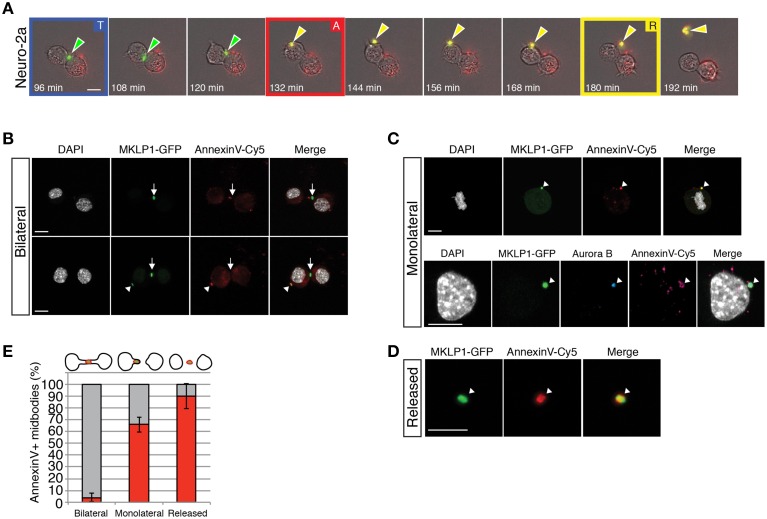
Phosphatidylserine is maintained on the outer-leaflet of the plasma membrane of retained and released midbodies in MKLP1-GFP Neuro-2a cells. (A) Individual frames of live-cell time-lapse video microscopy of a MKLP1-GFP stable expressing Neuro-2a cell line recoded at 12 min intervals (Supplementary Movie 1). Selected images of combined bright-field and epifluorescence channels are shown. Green-white arrows show the position of MKLP1-GFP positive midbodies. Yellow-white arrows indicate midbodies that bound to Annexin V-Cy5, which has been added to the medium and interacts with exposed PSs. “T” with blue frame, telophase; “A” with red frame, appearance of a Cy5 spot; “R” with yellow frame, released midbody. Scale bar, 10 μm. (B–D) MKLP1-GFP Neuro-2a cells were incubated with AnnexinV-Cy5 for 10 min in culture medium. Images are obtained as z-stacks every 0.38-μm and are maximum intensity projections. Scale bars, 10 μm. (B) Examples of bilateral midbodies. Fluorescence for MKLP1-GFP (green) and AnnexinV-Cy5 (red) combined with DAPI staining (white). White arrowheads show Annexin V-Cy5 positive midbodies and white arrows show Annexin V-Cy5 negative midbody. (C) Examples of monolateral midbodies. Upper panels, fluorescence for MKLP1-GFP (green), Annexin V-Cy5 (red), and DAPI (white). Lower panels, fluorescence for MKLP1-GFP (green), Aurora B kinase (blue), Annexin V-Cy5 (red), and DAPI (white). White arrowheads, Annexin V-Cy5 positive midbody. (D) Example of a released Annexin V-Cy5 positive midbody. Fluorescence for MKLP1-GFP (green) and AnnexinV-Cy5 (red). (E) Quantification of MKLP1-GFP and Annexin V-Cy5 colocalization (red columns) vs. non-colocalization (gray columns), expressed as percentage of total number of MKLP1-GFP+ midbodies. Data are the mean four independent experiments, counted in at least 20 randomly chosen fields (total number of counted particles, 243 for bilateral, 234 for monolateral and 137 for released); error bars indicate SD.